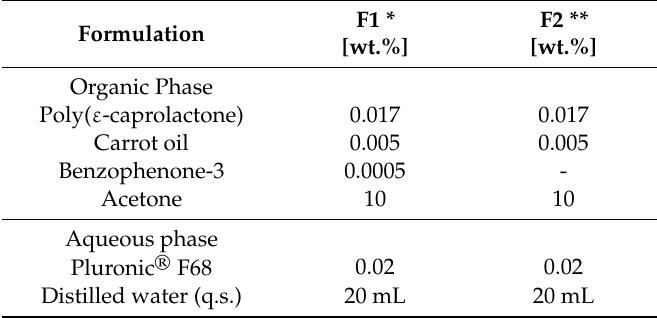
Table 1. Composition of polymeric nanocapsules